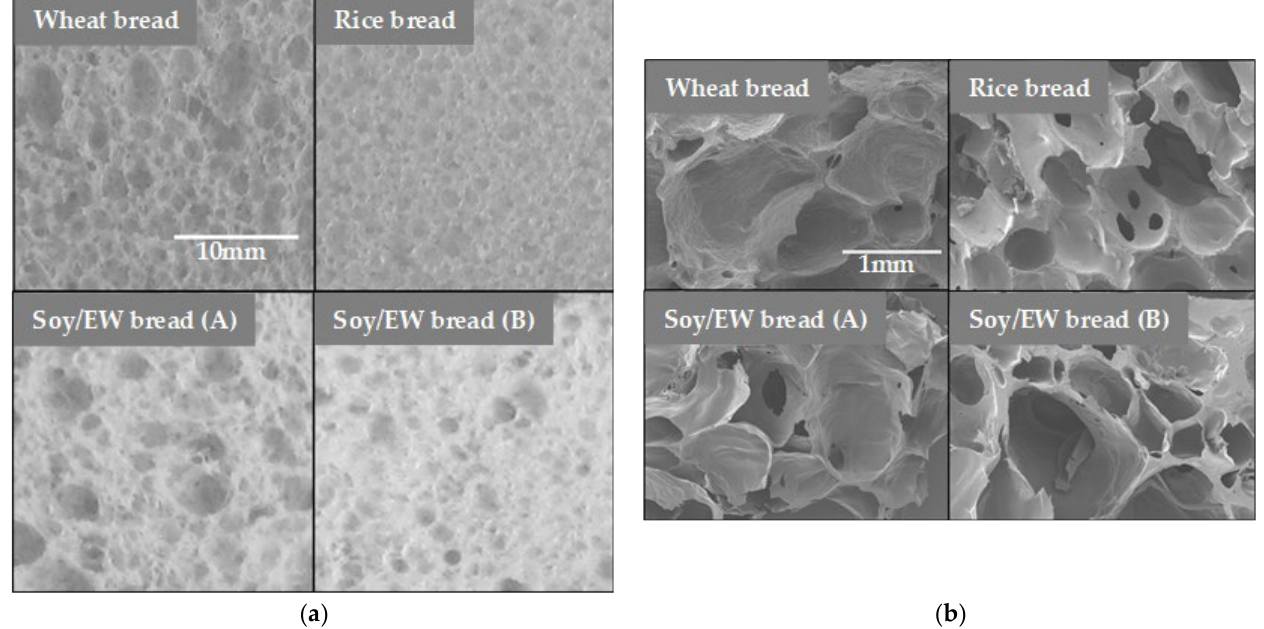
Figure 2. Cross-section of the breads. Observation under optical microscope ( a ) as well as under scanning electron microscope ( b ). Soy/EW bread indicates bread made of soy protein and raw egg white without (A) or with starch (B). Reprinted/adapted with permission from Ref. [23]. Copyright 2021,